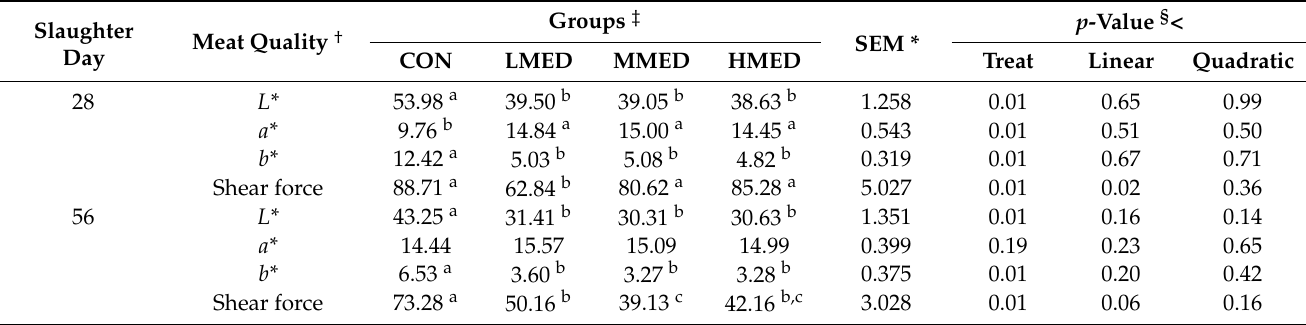
Table 5. Effects of supplemental feeding diets with three levels of metabolizable energy (ME) on meat quality of grazing Swan